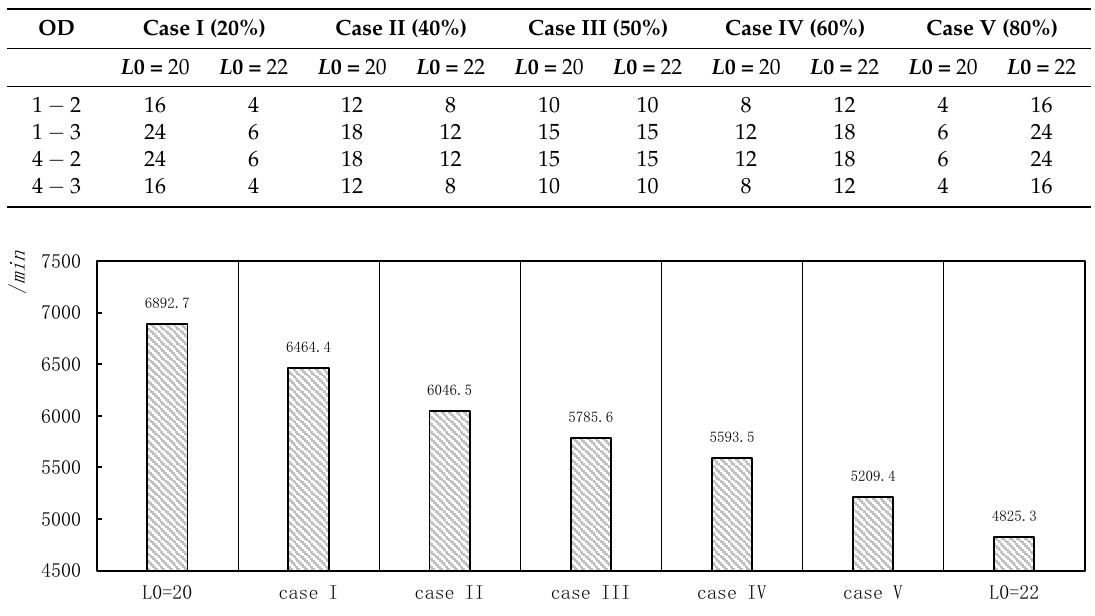
Figure 9. Comparison of the total trip time for various cases.